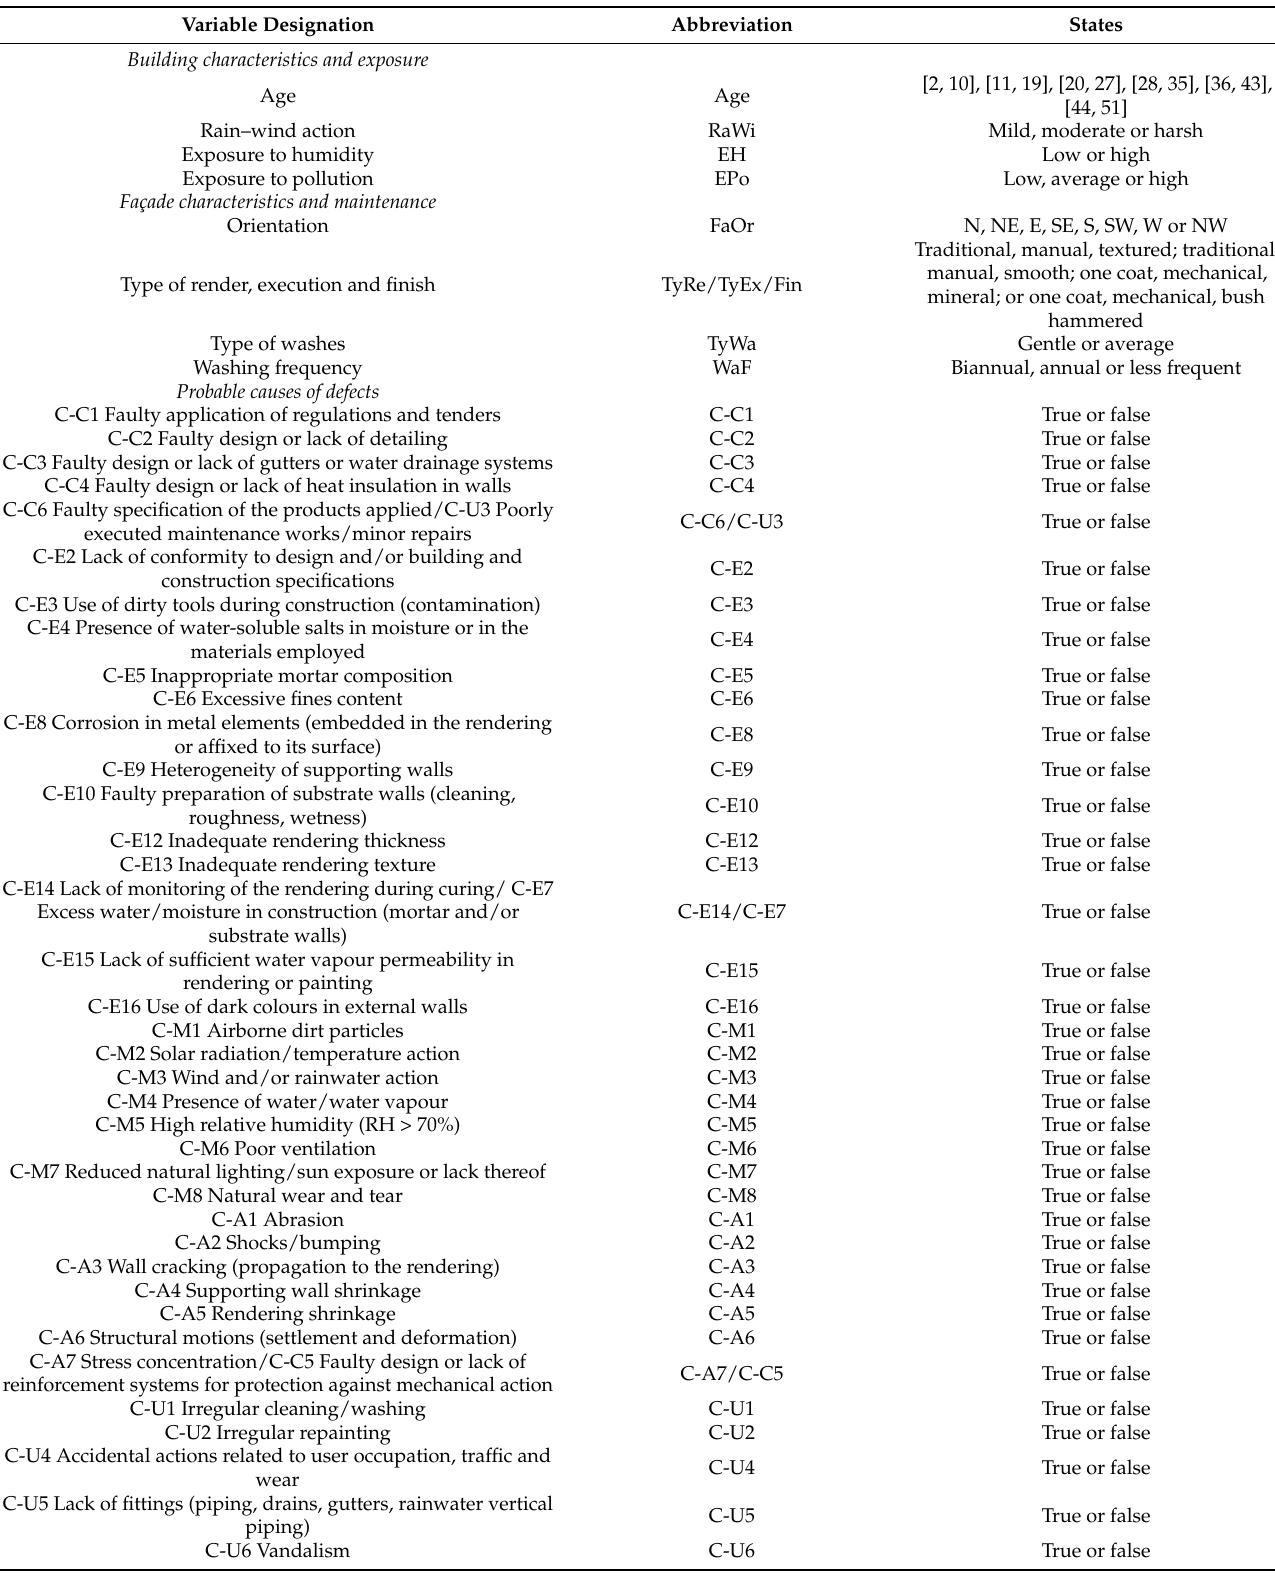
Table 1. Variables in the BN model and respective states (based on